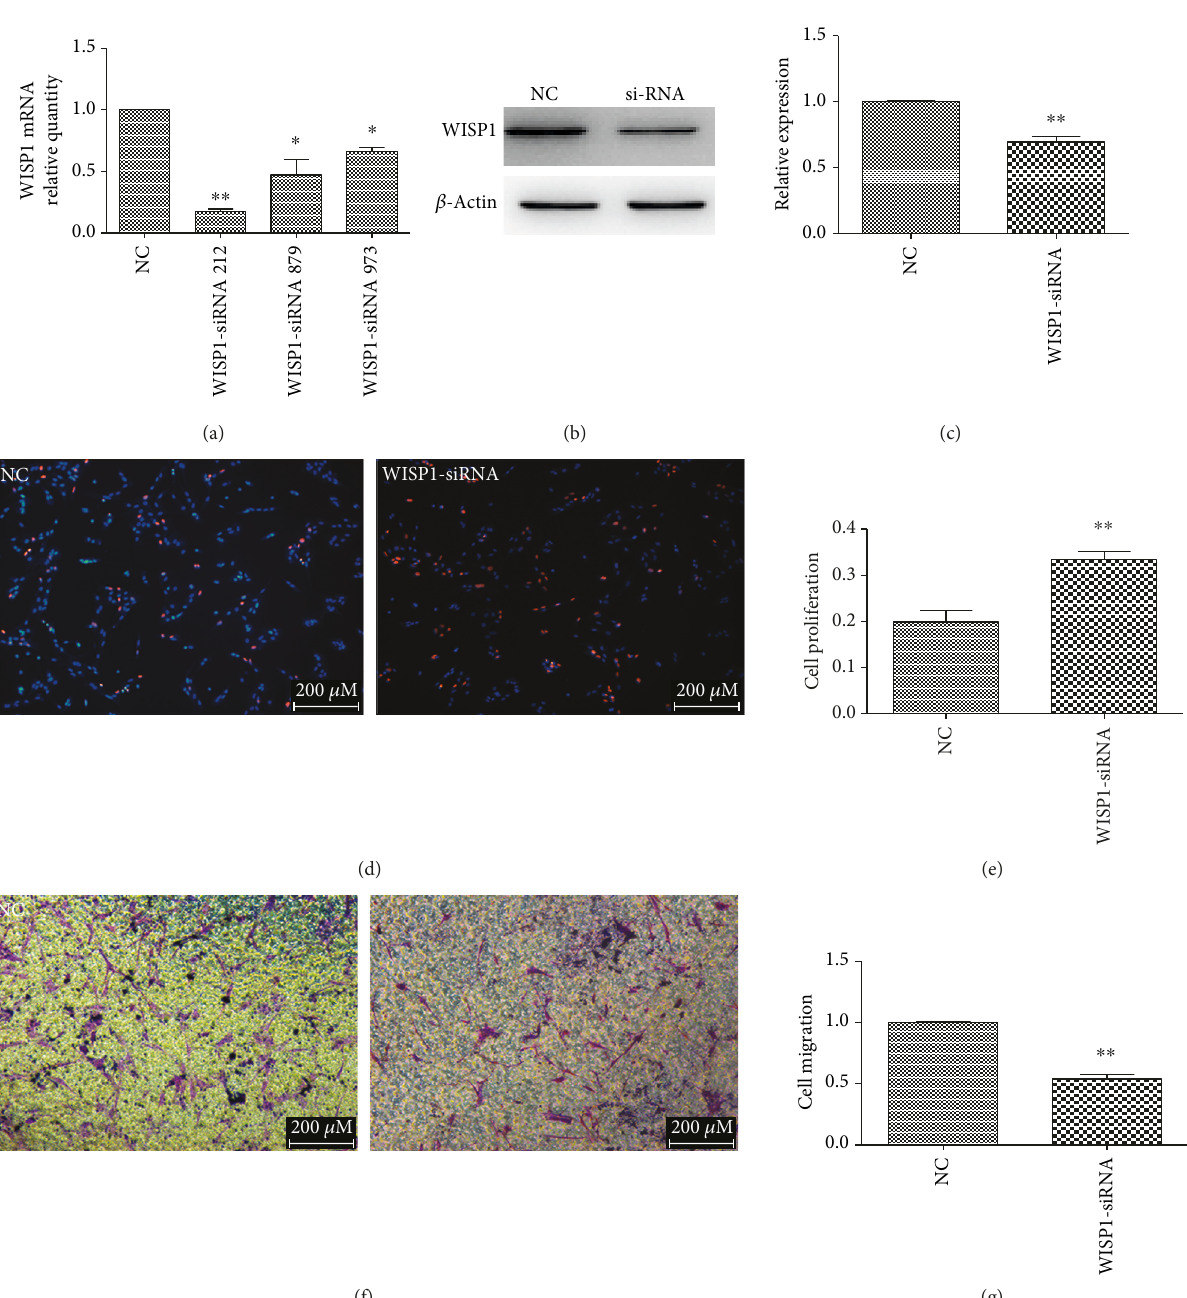
Figure 17: The proliferation and migration of astrocytes after transfected by WISP1 si-RNA. NC: negative control group ( ∗ P < 0 05 ). (a) qRT- PCR showed that the expression of WISP1 in astrocytes transfected with WISP1 si-RNA. (b) Western blot showed that WISP1 si-RNA could decreased the expression of WISP1 protein. (c) The statistic graph of (b). (d) Proliferation of astrocytes transfected with WISP1 si-RNA compared with the normal group. (e) The statistic graph of (d) ( ∗∗ P < 0 01 ). (f) The migration of astrocytes transfected with WISP1 si-RNA compared with the normal group. (g) The statistic graph of (f) ( ∗∗ P < 0 01